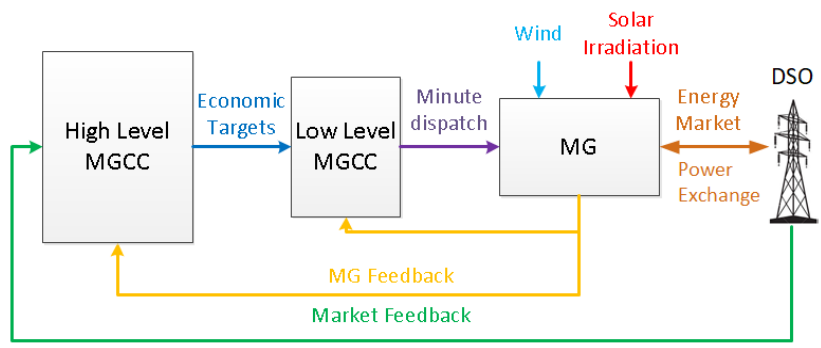
Figure 1. Proposed microgrid central controller (MGCC).